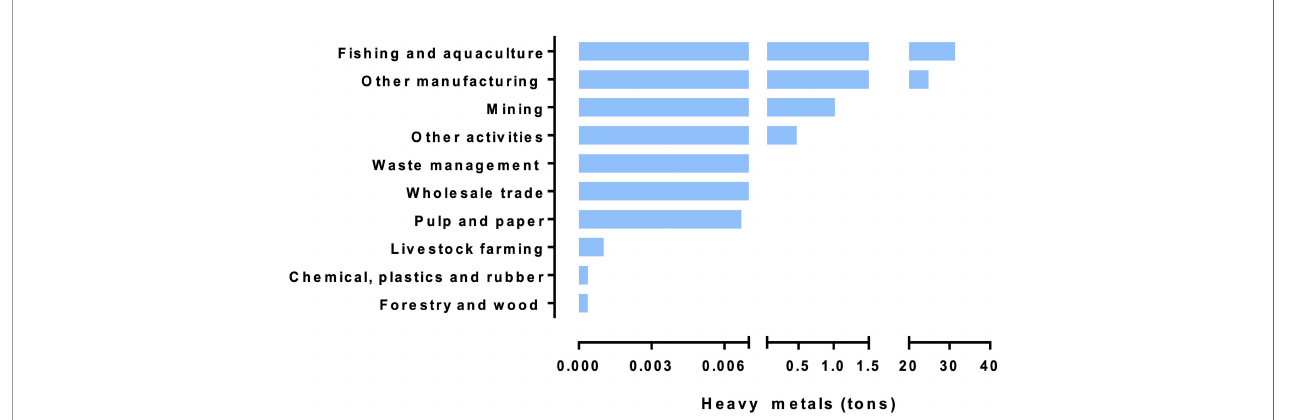
FIGURE 4 | Contribution of heavy metals discharged by diverse industries in Los Lagos Region during 2019. Heavy metals are expressed in tons (x-axis). Different industries are listed in y-axis. Data source: http://datosretc.mma.gob.cl/dataset/emisiones-al-agua/resource/041eb3e7-87b0-4be3-a980-4c837b02e97f and https:// snifa.sma.gob.cl/Estadisticas/Resultado/5.